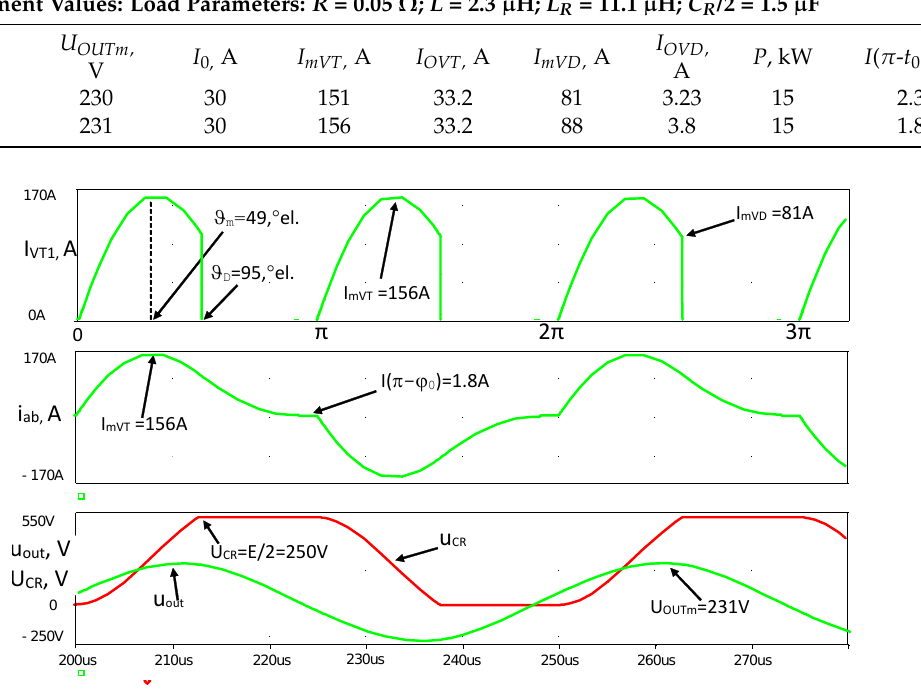
Figure 5. Timing diagrams of half-bridge RI with ED and split resonant capacitor — computer experiment.